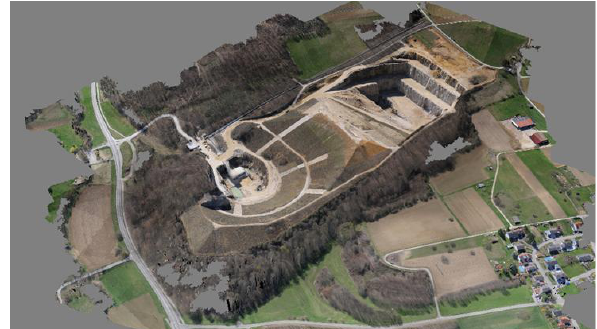
Figure 7. Automatically generated DSM (digital surface model) of an open pit mine with draped ortho-photo created from ca. 300 images taken with the SUSI 62